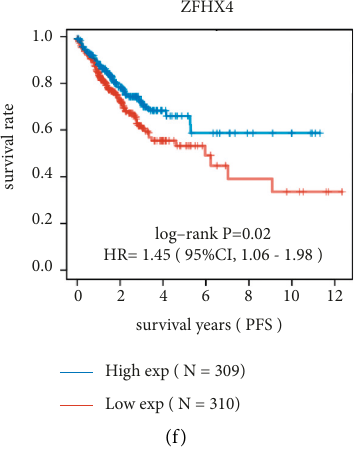
Figure 3: The dysregulation of somatically mutated genes was correlated to the prognosis of CRC. (a) 20 genes dramatically changed between the normal colon tissue and CRC group. Among them, DNAH5, TP53, OBSCN, LRP2, NEB, PCLO, MUC16, USH2A, and CCDC168 significantly upregulated. CSMD1, SYNE1, RYR1, RYR3, APC, ADGRV1M, DCHS2, KRAS, LRP1B, and FAT4 significantly downregulated. High expression of CSMD3 (b), DCHS2 (c), LRP2 (d), RYR2 (e), and ZFHX4 (f) significantly negatively correlated with shorter PFS in